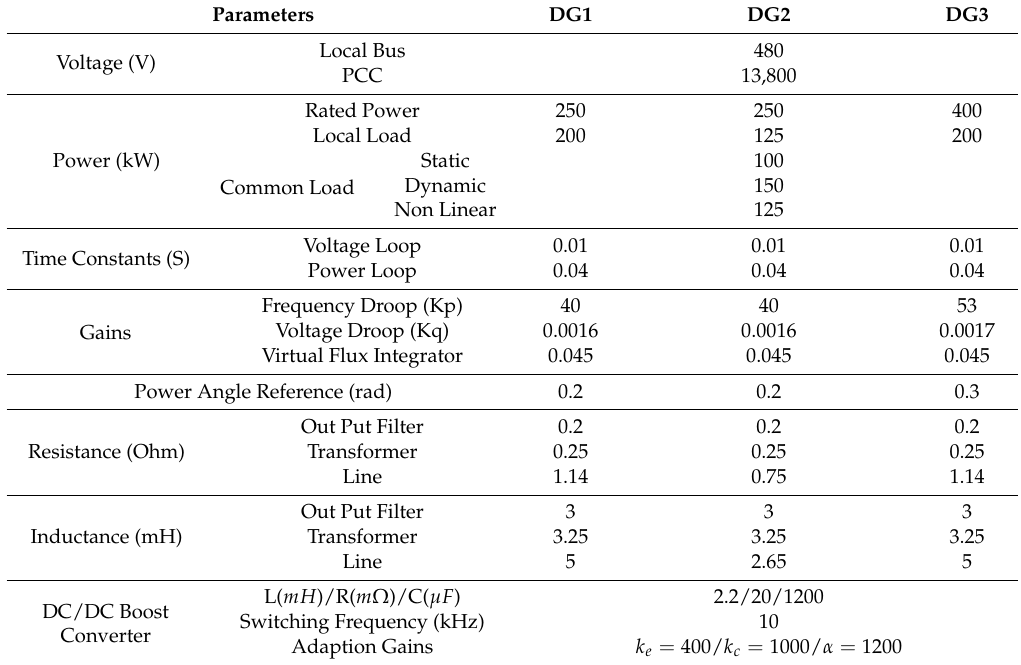
Table A1. System